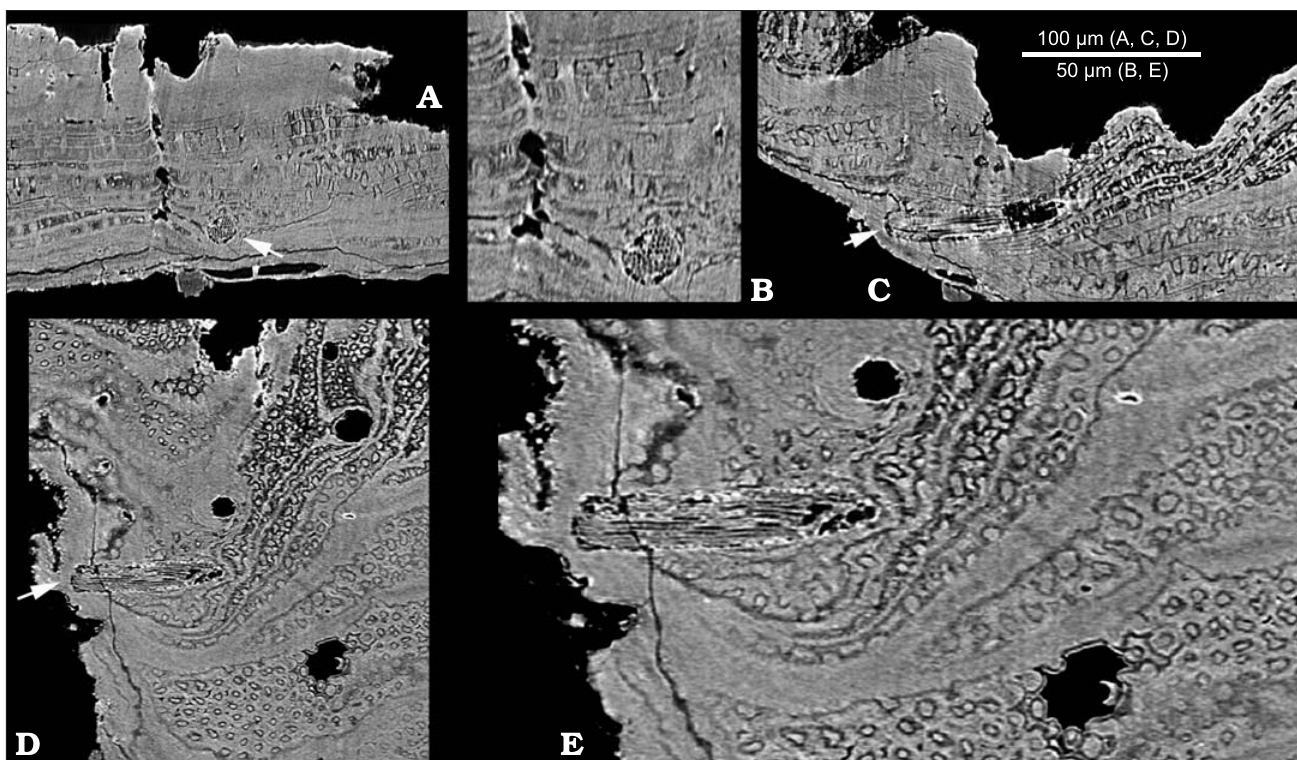
Fig. 3. Stem-group brachiopod Oymurania gravestocki Ushatinskaya in Kouchinsky et al., 2015 (SMNH X5302) from the lower Cambrian Perekhod Formation, Achchagyi-Kyyry-Taas section, Siberia. SRXTM slices showing a phosphatized seta inside a tangential canal (arrowed in A, C, and D). A . Section crossing perpendicularly to the tangential canal. B . Close-up of A showing cross-sections of filaments (microvilli). C . Longitudinal section in radial direction through the tangential canal. D . Longitudinal section oblique to the shell surface through the tangential canal. E . Close-up of D showing microvillar composition of the seta, lamellae consisting of acrotretoid columns perpendicularly penetrated by the Micrina – Setatella type